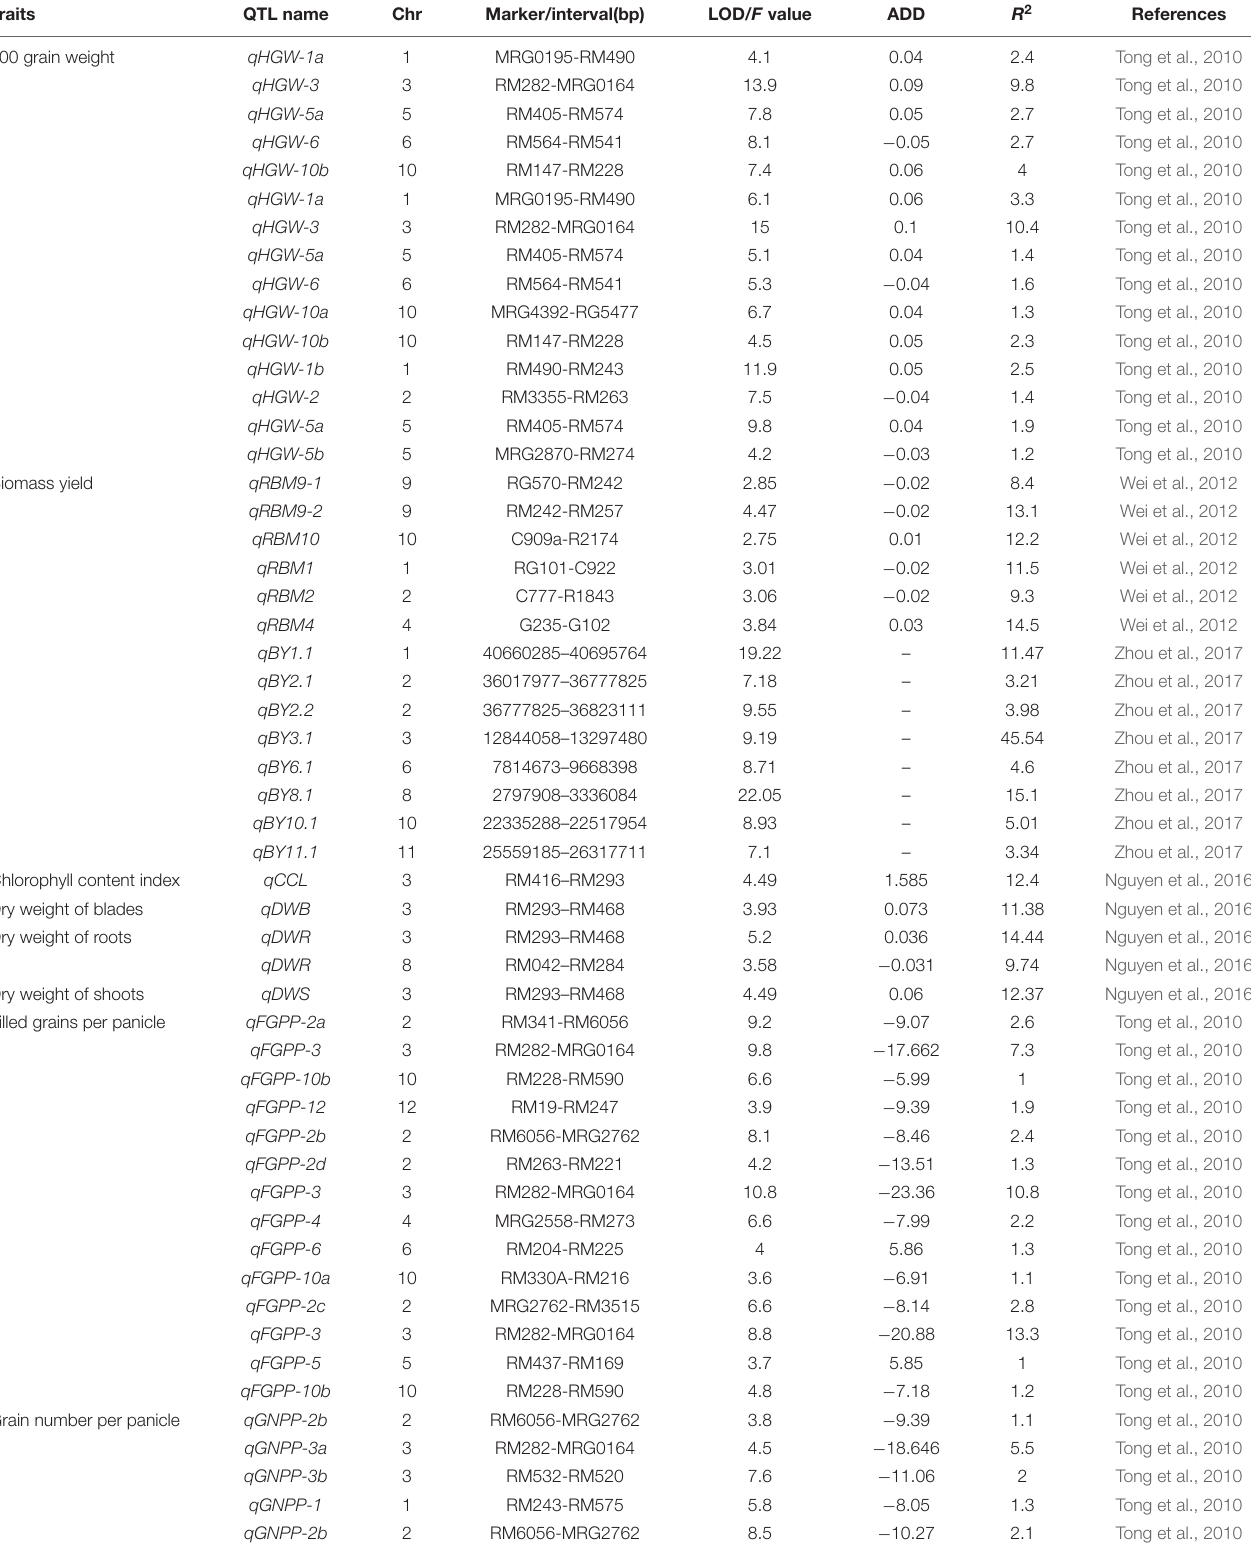
TABLE 1 | Detailed description of QTL associated with nitrogen use efficiency-related traits in rice.